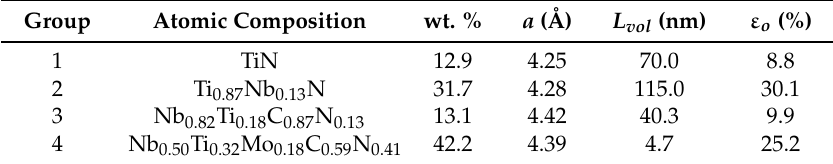
Table 2. QXRD values for composition, weight fraction, and microstructure dependent variables. Group